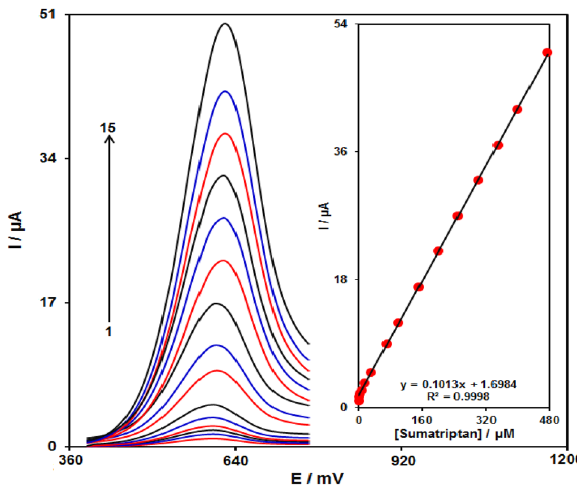
Figure 11. DPVs of Fe 3 O 4 @ZIF-8/SPGE in 0.1 M PBS (pH 7.0) including sumatriptan varying concentrations. 1–15 indicate 0.035, 0.2, 2.5, 7.5, 15.0, 30.0, 70.0, 100.0, 150.0, 200.0, 250.0, 300.0, 350.0, 400.0 as well as